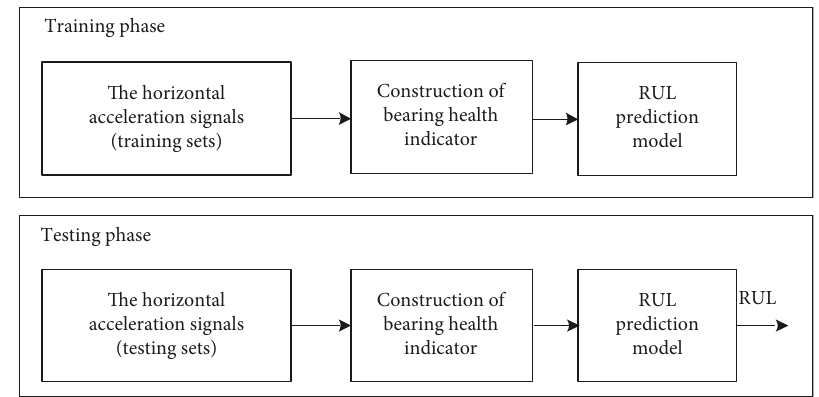
Figure 1: Flow chart of the proposed method.